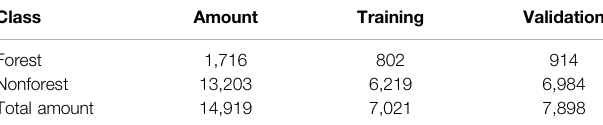
TABLE 2 | Amount and class of samples selected in the QTP